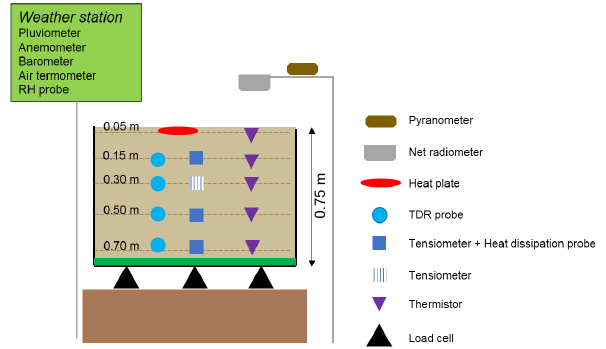
Figure 4. Monitoring devices installed in the physical model (Ri- anna et al., 2014a,